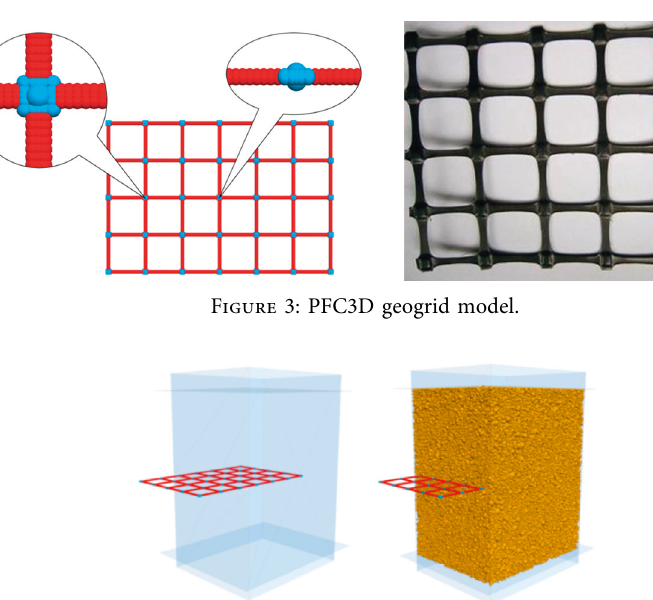
Figure 2: Schematic of particle combinations in the model. (a) Spherical particle, (b) Ellipsoidal-like particle, (c) Tetrahedron-like particle.